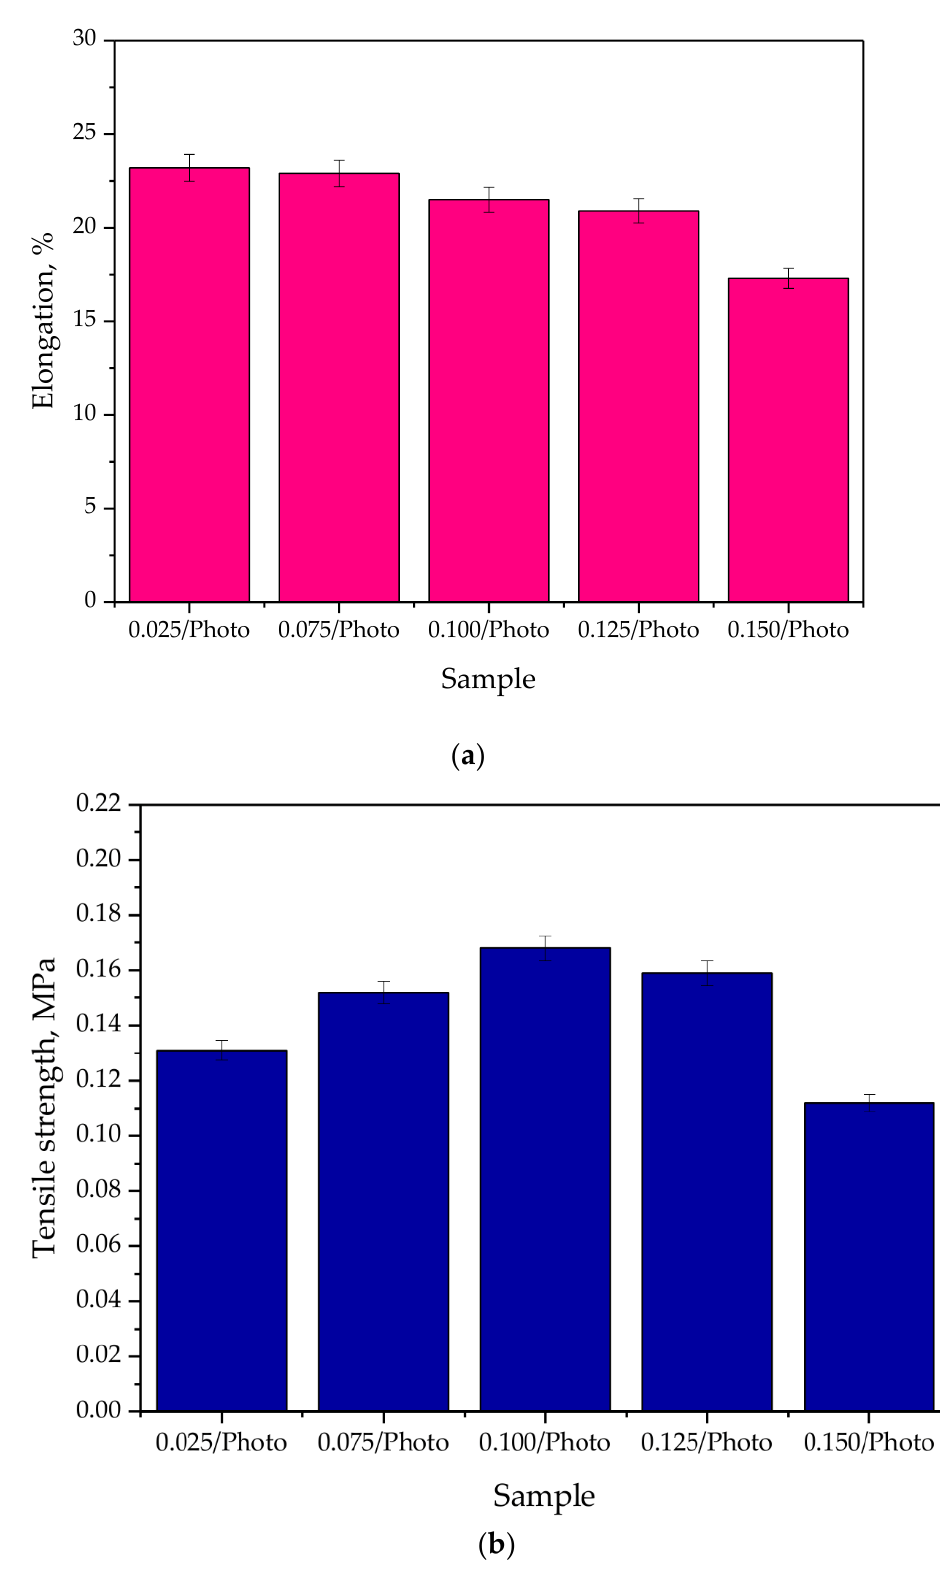
Figure 9. Results of mechanical studies of hydrogels showing their percentage elongation ( a ) and the tensile strength ( b ).